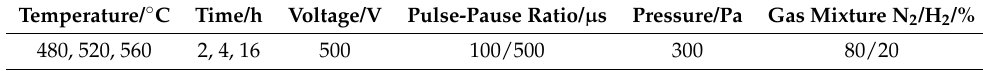
Table 2. Plasma nitriding